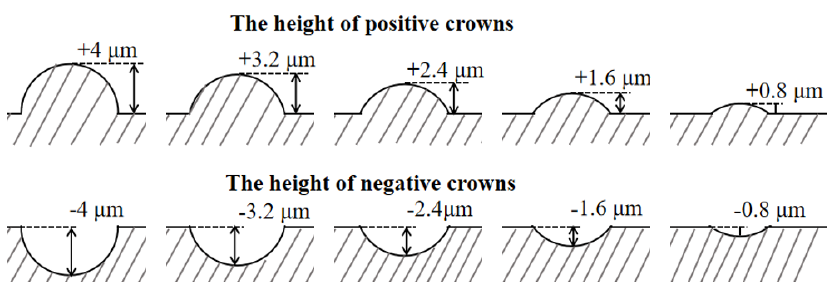
Figure 2. Ten different heights of spherical crowns used in this paper show in this illustration, the heights of these crowns are from +4 µ m to − 4 µ m. Each height of the crown constitutes a three- dimensional spherical crown microstructure.